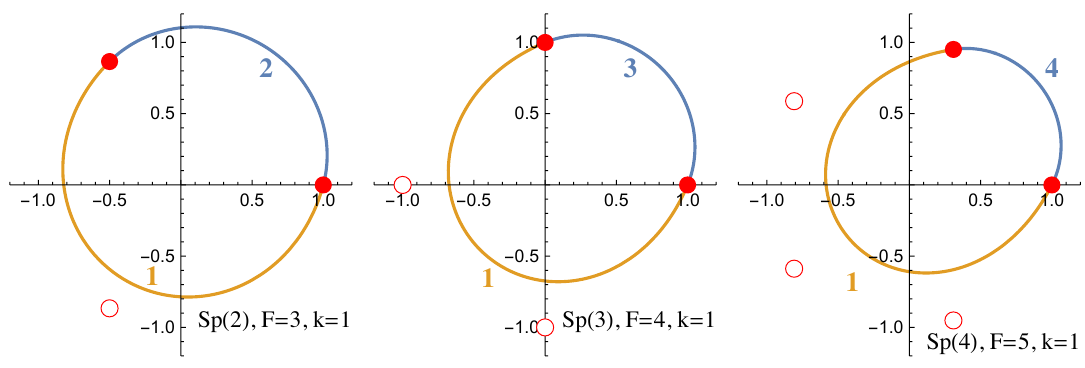
Figure 1 . Examples of 1-walls in Sp( N ) SQCD with F = N + 1 flavors. We draw the trajectories of the eigenvalues of the meson matrix M in the complex plane along the domain-wall transverse direction x . The filled red circles represents the expectation values of the vacua at x = ±∞ , whereas the unfilled red disks represent the expectation values of the other vacua. The eigenvalues along 1-walls split into a group of k = 1 (in yellow) and a group of k = N (in blue) elements. 1 2 The number of eigenvalues that follow a given trajectory is indicated in the figures with a number colored like the trajectory it refers to.